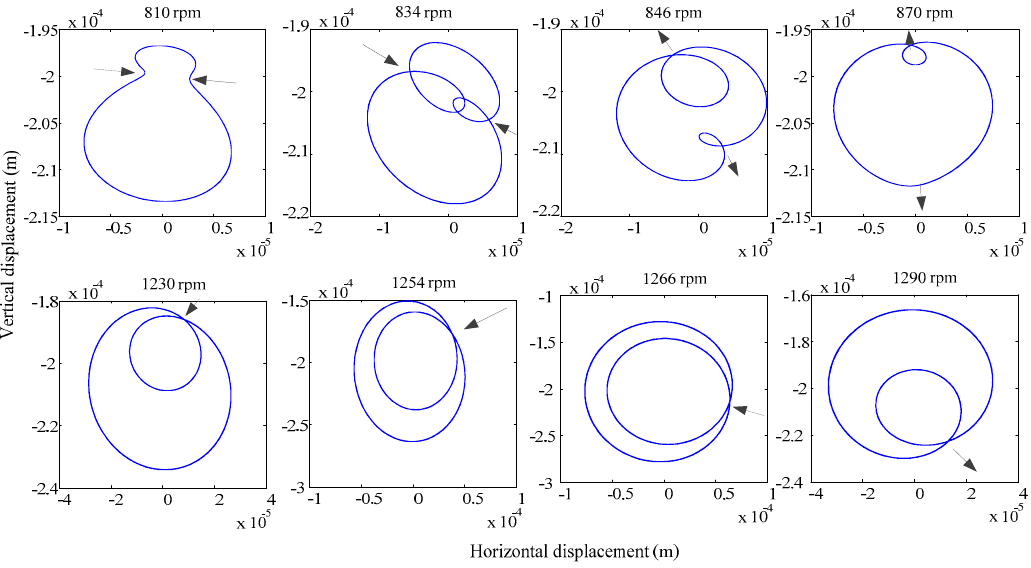
Figure 4. Whirl orbits of the cracked rotor in the neighborhood of 1/3 (top row) of and 1/2 (bottom row) of the critical rotating speed.